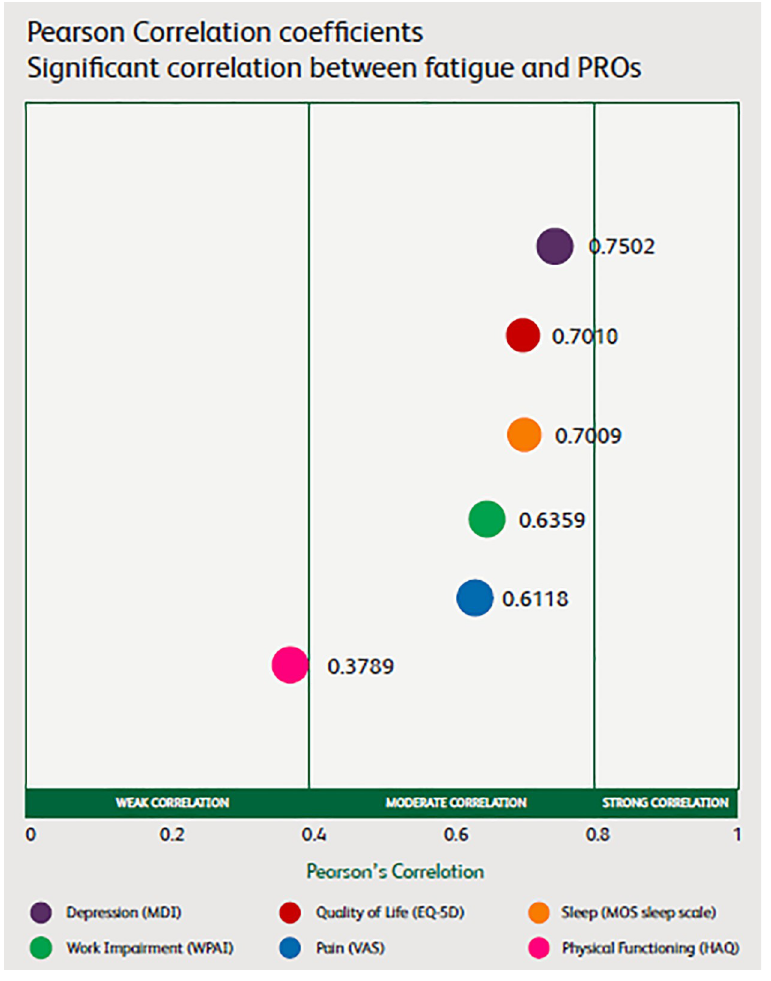
Fig 1. Pearson correlation coefficients between fatigue and